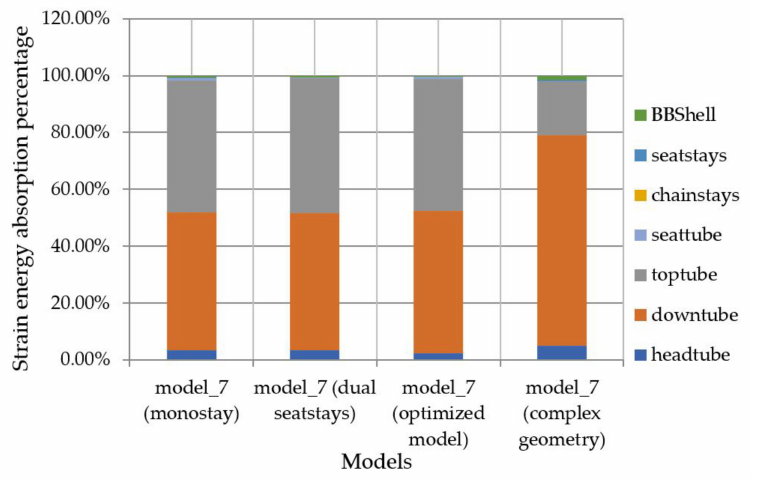
Figure 21. Absorption of strain energy and its distribution in out-of-plane loads on head tube scenario.